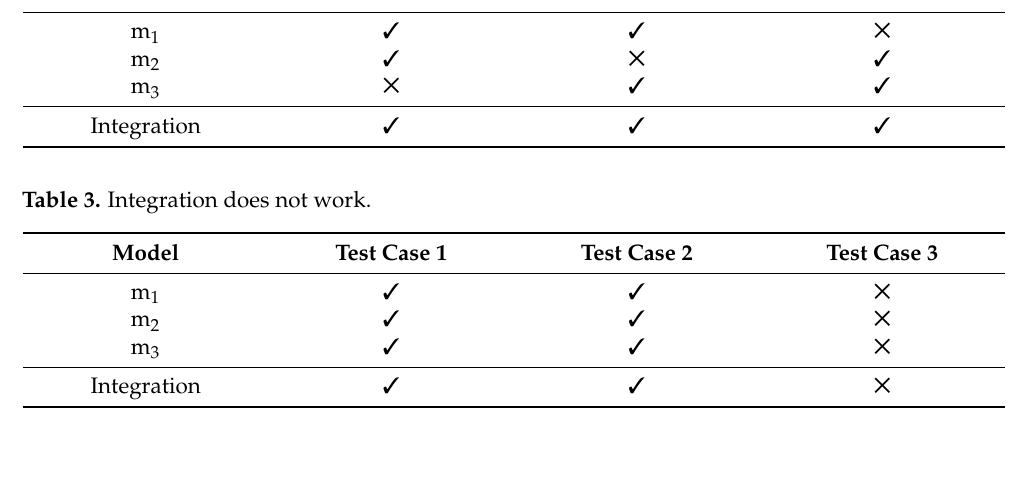
Table 2. Positive effects of integration.